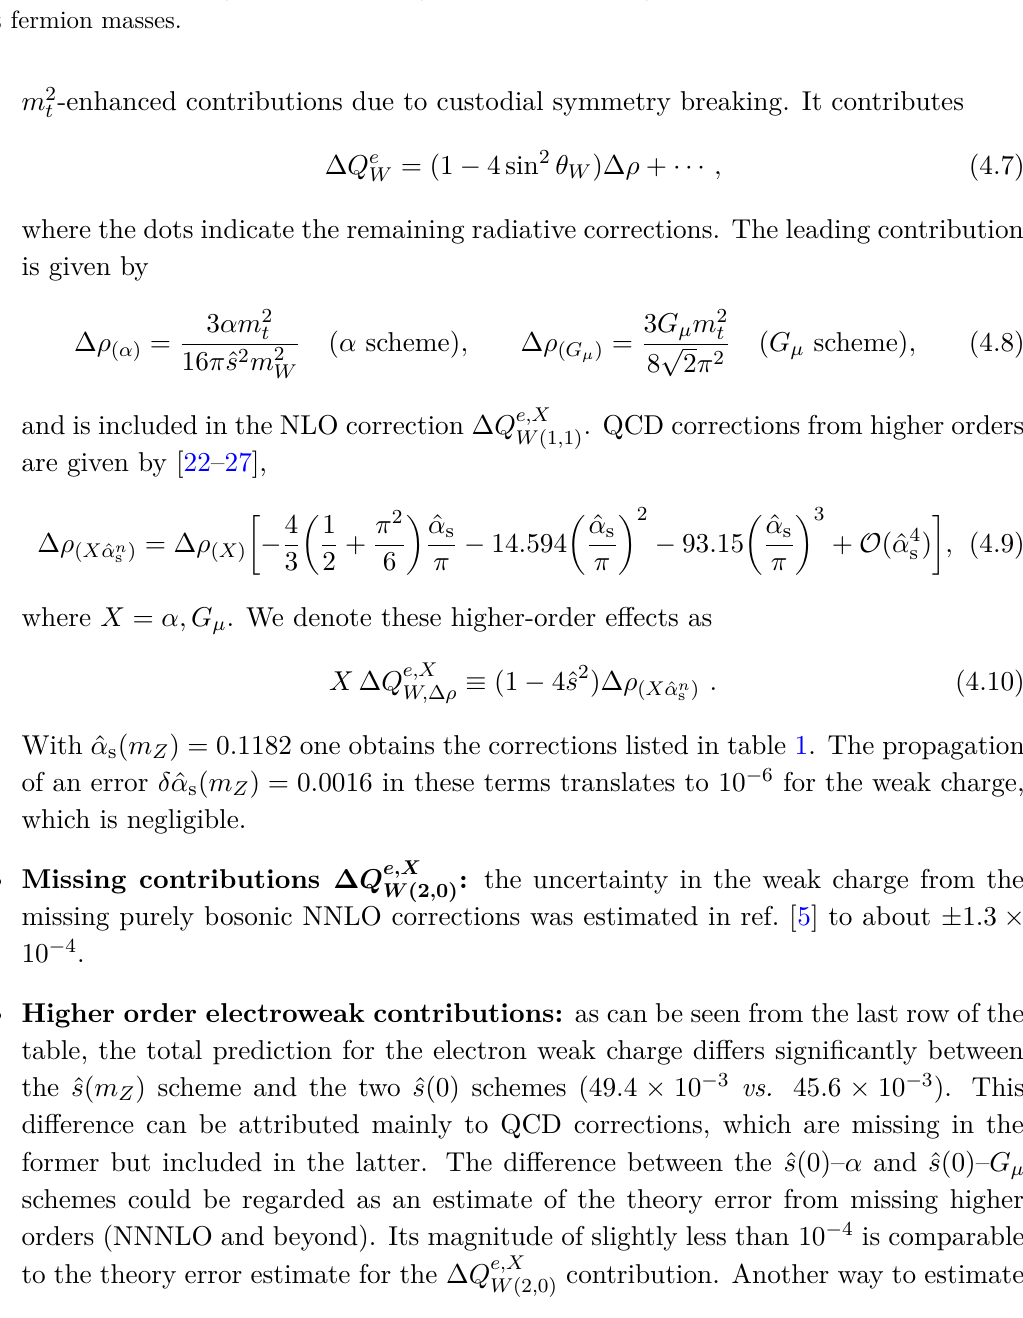
Figure 1 . Two-loop diagrams contributing to Møller scattering with a non-trivial dependence on light fermion